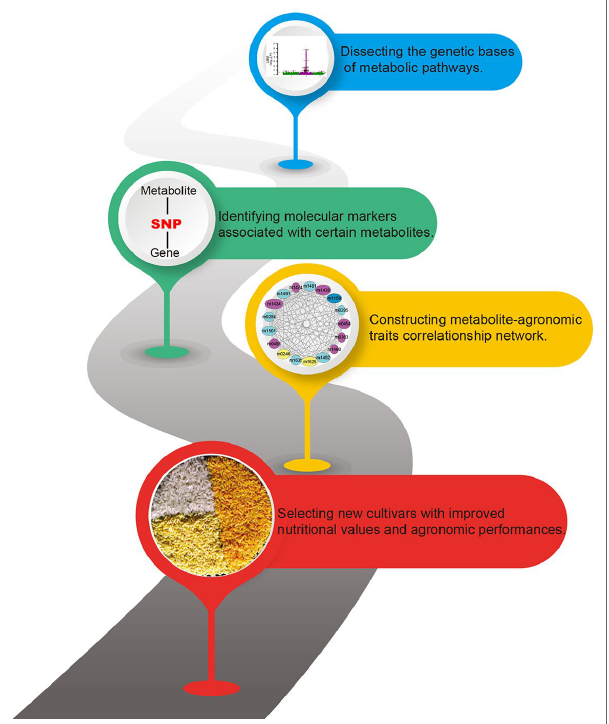
FIGURE 2 | Contributions of metabolomics for metabolome-assisted breeding. This flow chart shows how the metabolome can be used to guide the improved quality of crops. Multi-omics integration analysis is used to analyze the genetic basis of crop nutrients, to explore molecular markers that determine the content of nutrient metabolites, and to establish an interaction network of metabolites, markers, genes, and important agronomic traits to guide the precise breeding of metabolome assisted. The figure is modified with permission from Elsevier (Al-Babili and Beyer,